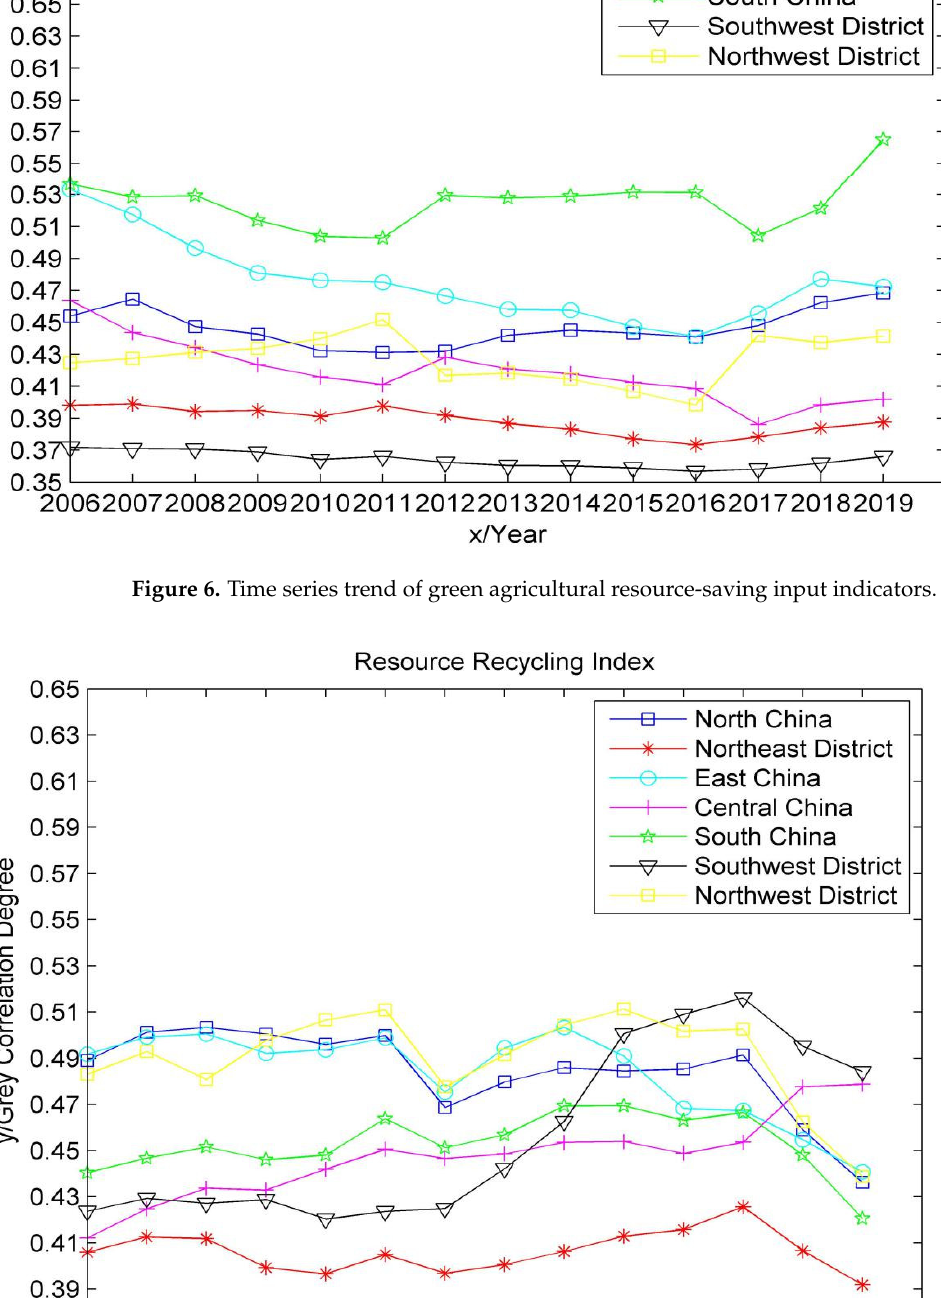
Figure 7. Time series trend of green agricultural resource recycling indicators.